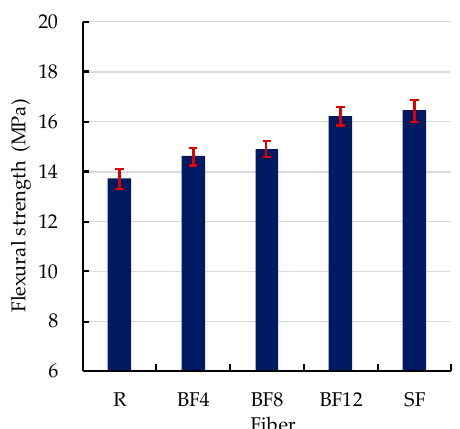
Figure 5. Effect of basalt fiber content and fiber type on the flexural strength of RPC.